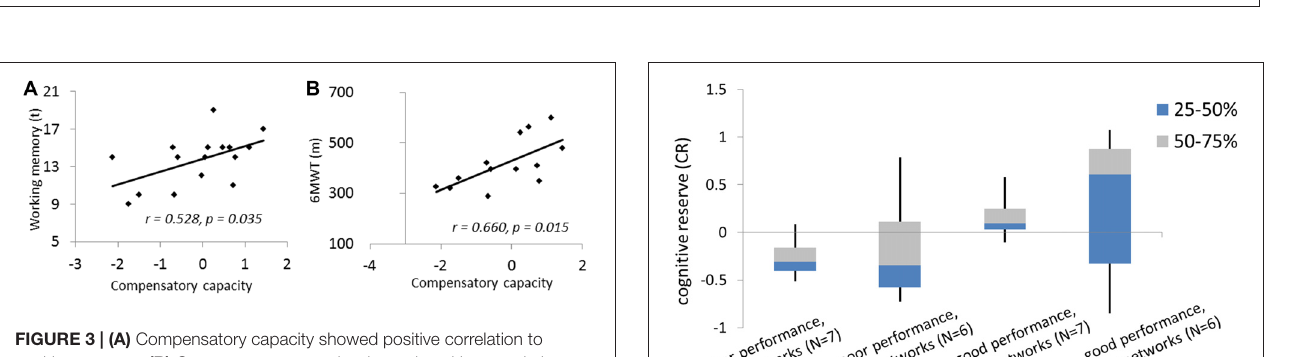
FIGURE 2 | (A) The top three core networks derived from independent component analysis (ICA) that commonly activated in a majority of subjects. ICA maps were converted to z statistic images, thresholded at z > 2.3; (B) number of activated networks showed negative correlation to gray matter (GM) volume in the attention network (ATN); (C) number of activated networks showed negative correlation to GM volume in the total three core networks.